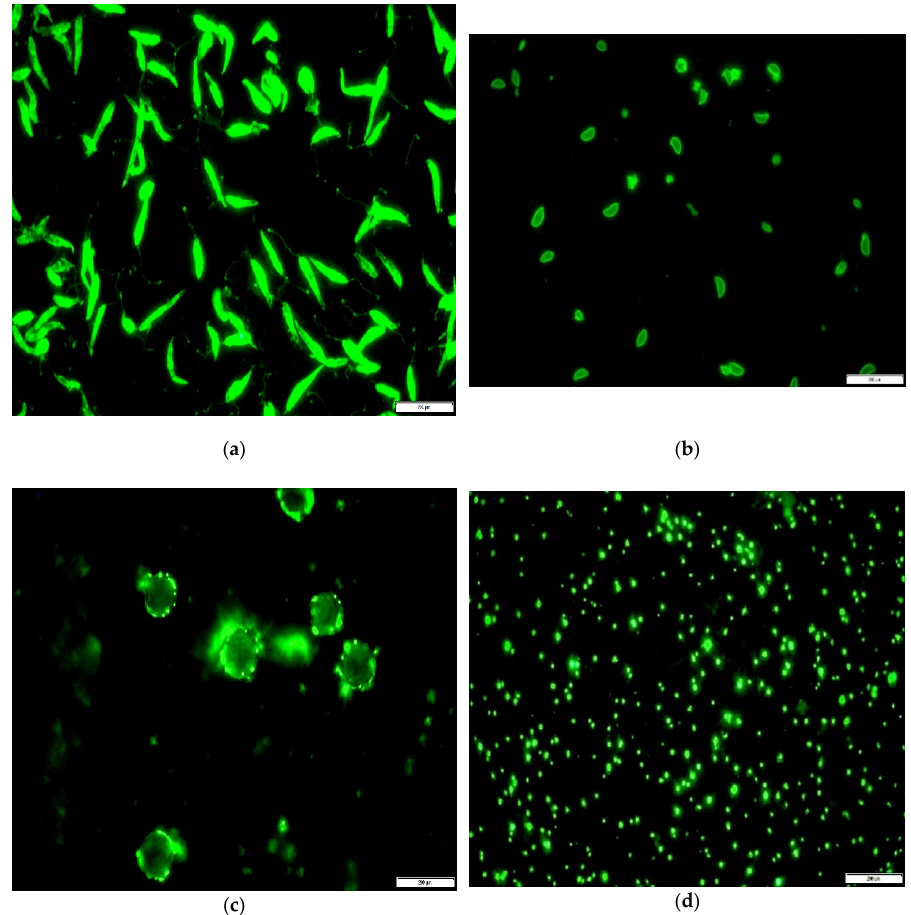
Figure 1. Image of Indirect Immunofluorescence Antibody (IFA) assay observed by a Nikon Eclipse fluorescence microscope (objective × 100). ( a ) L. infantum positive IgG antibody reaction, serum titer 1:25; ( b ) T. gondii positive IgG antibody reaction, serum titer 1:25, ( c ) A. phagocytophilum positive IgG antibody reaction, serum titer 1:25 and ( d ) B. caballi positive IgG antibody reaction, serum titer 1:50.